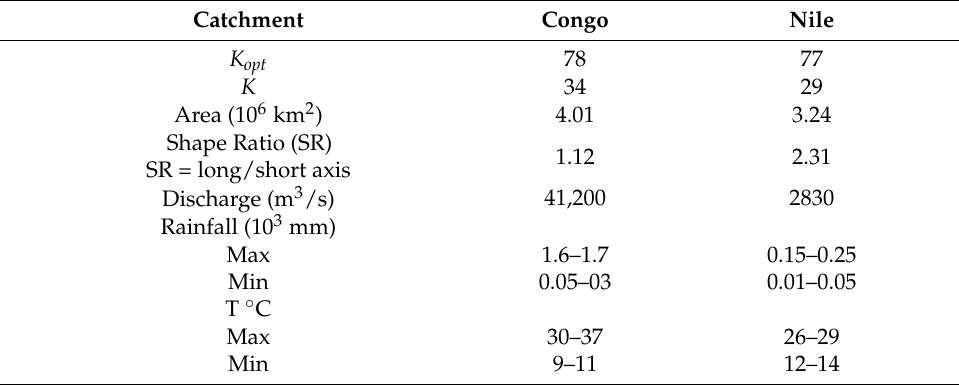
Table 1. Some characteristics of the drainage basins of the Congo and Nile